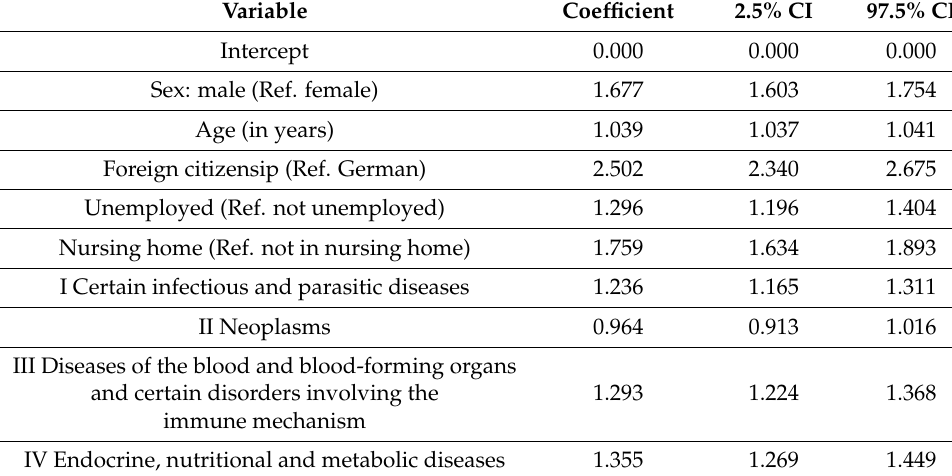
Table 1. Regression coefficients for COVID-19 hospitalizations.